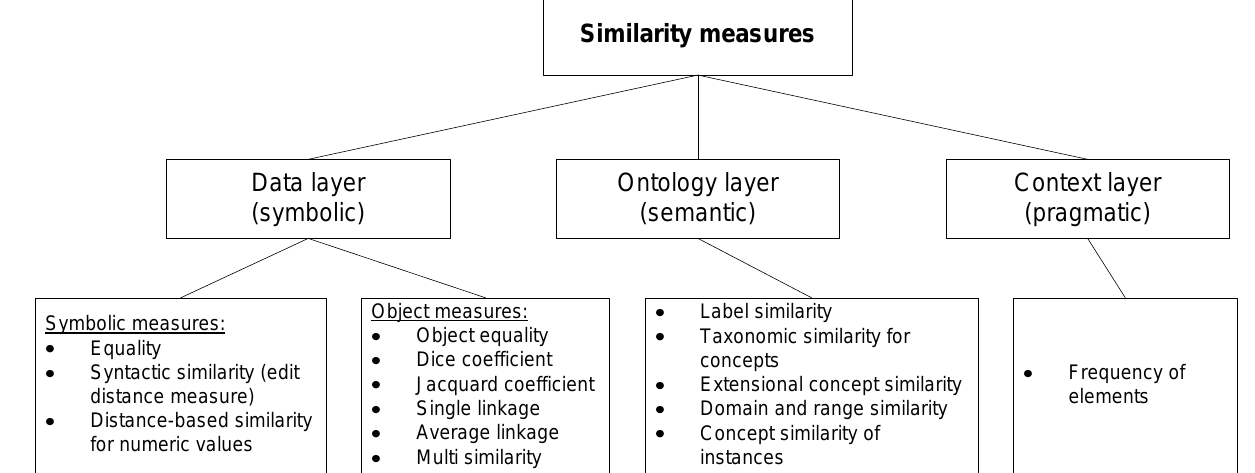
Fig. 2. Division of similarity measures, based on Ehrig [7] because they require specific knowledge.